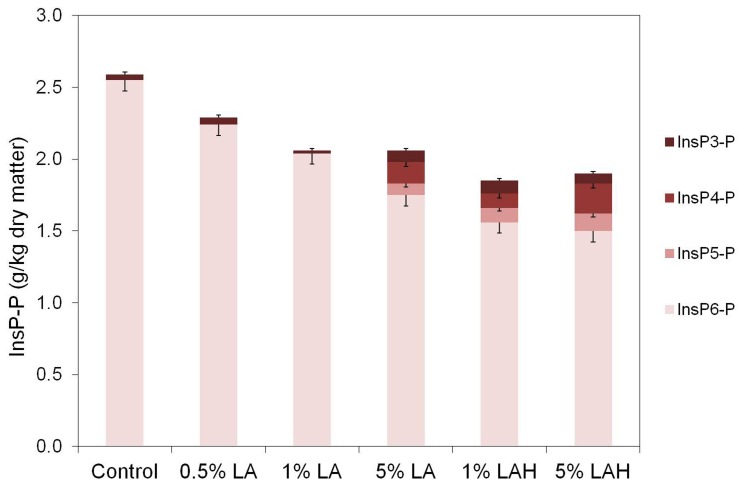
The concentrations of P pertaining to myo-inositol tri- to hexakisphosphate (InsP3-P, InsP4-P, InsP5-P, and InsP6-P) and to the sum of them (total InsP-P) in untreated barley (control) or barley soaked in increasing concentrations of lactic acid at room temperature in 22°C (LA) or oven-heated at 55°C (LA-H).Data are shown as least square means ± standard error of the mean (n = 3). For InsP3-P: all contrasts P>0.10; for InsP4-P: control vs. LA P = 0.50, control vs. LA-H P = 0.030, LA vs. LA-H P = 0.097; for InsP5-P: control vs. LA P = 0.10, control vs. LA-H P<0.001, LA vs. LA-H P = 0.006; for InsP6-P: control vs. LA P<0.001, control vs. LA-H P<0.001, LA vs. LA-H P<0.001; for the sum of InsP-P: control vs. LA P<0.001, control vs. LA-H P<0.001, LA vs. LA-H P = 0.055.